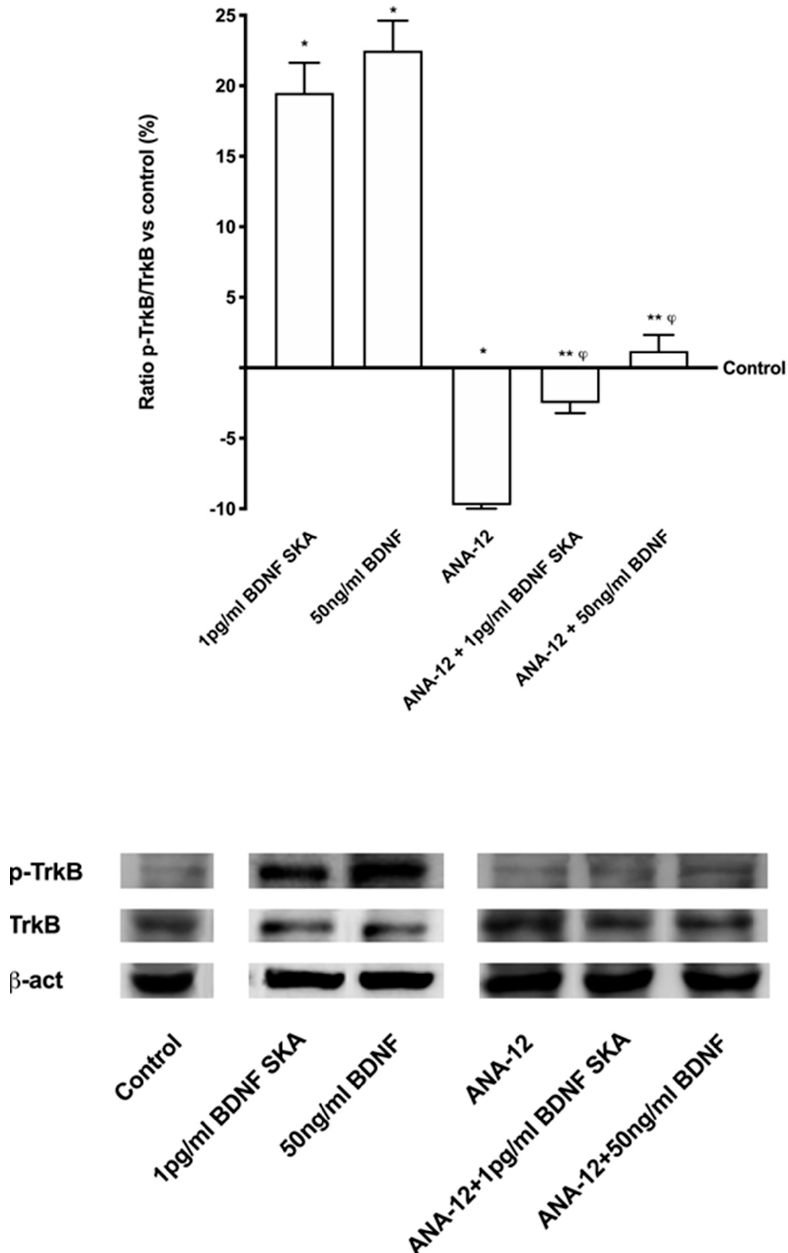
Figure 4. Analysis of TrkB receptor under blocking condition on astrocytes. In the upper panel densitometric analysis and in the lower panel an example of Western blot is reported. Data are expressed as means ± SD (%) of five independent experiments normalized on specific total protein and verified by β -actin detection. ANA-12 = 1 µ g / mL ANA-12. * p < 0.05 vs. control; ** p < 0.05 ANA-12; ϕ p < 0.05 vs. the same treatments without ANA-12.